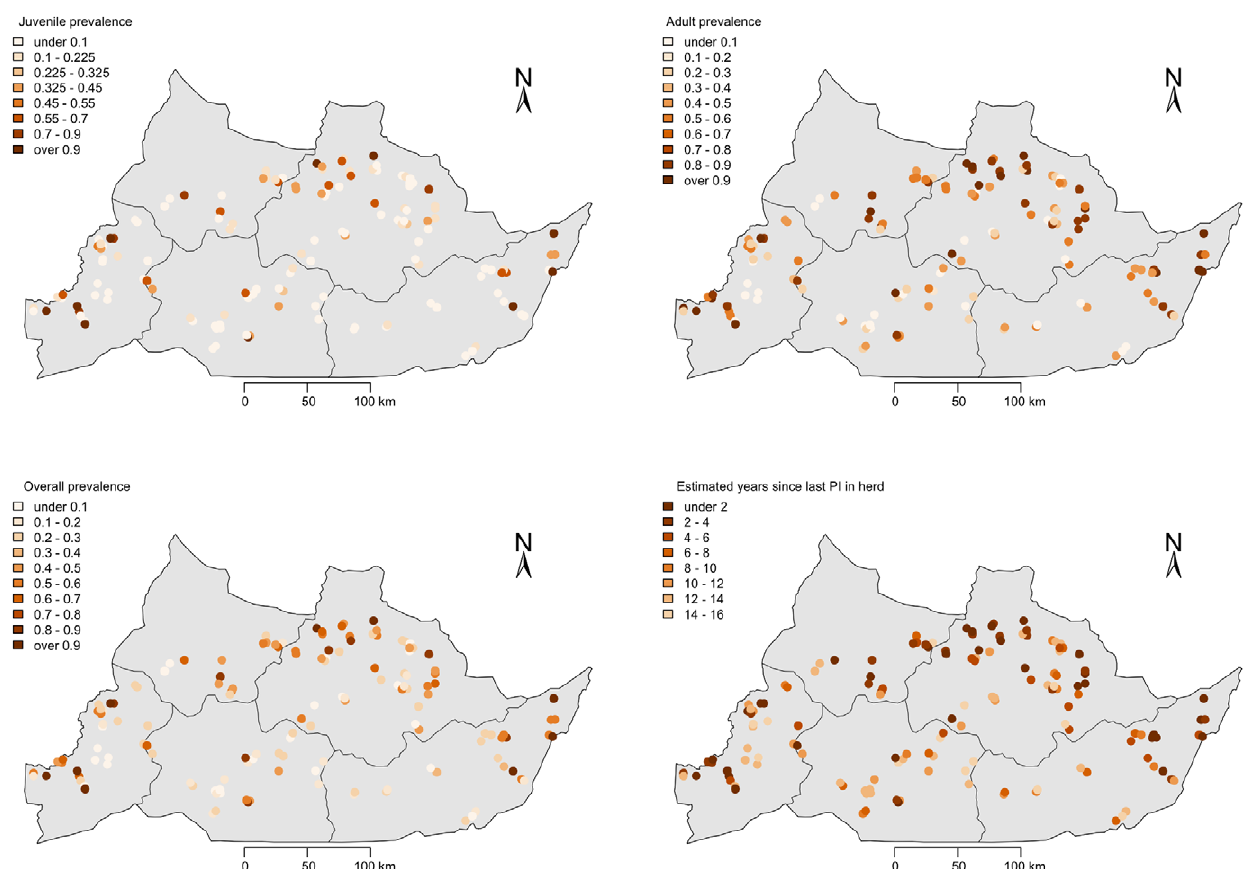
Figure 6. Maps of the Adamawa Region of Cameroon showing location of sampled herds and (a) within herd pestivirus seroprevalence based on juveniles only, (b) within herd pestivirus seroprevalence based on adults only, (c) overall within herd pestivirus seroprevalence and (d) the estimated years since last PI calf was in each herd.